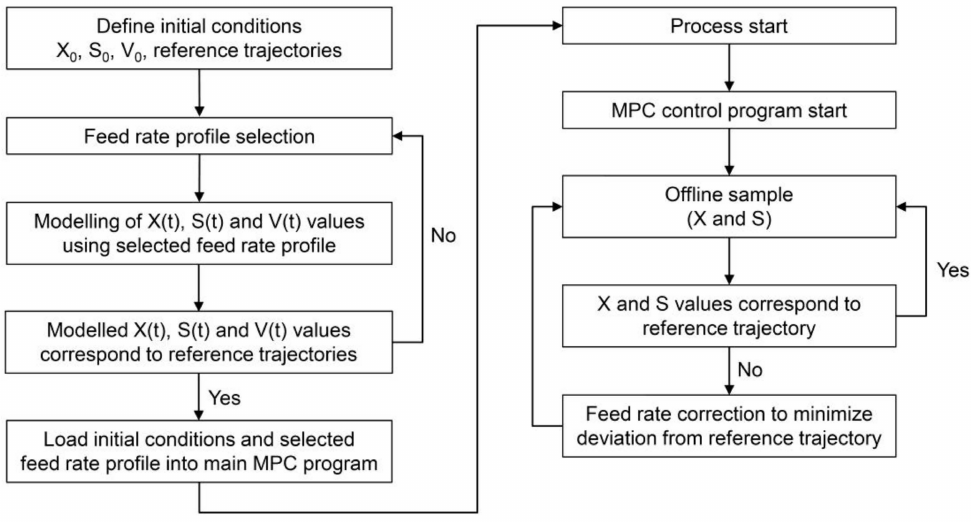
Figure 12. The schematic algorithm of the MPC